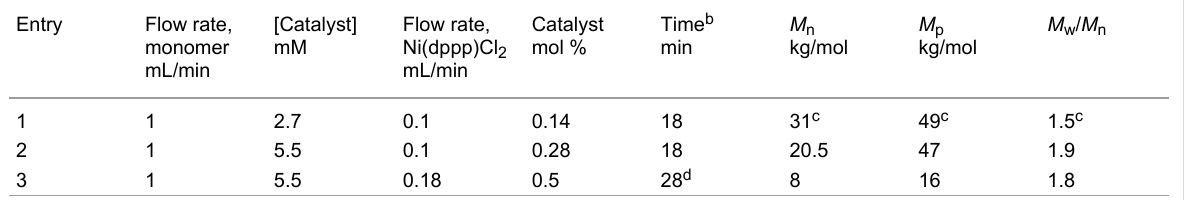
The regioregularity was estimated to be 95% from the integra- tion of the α -methylene protons in the 1 H NMR spectrum (Figure 4). The same degree of regioregularity was observed for a batch sample of similar molecular weight. Additionally, the variation of the molecular weight was investigated when the [M] 0 /[I] 0 ratio was varied. As expected, increasing the concen- tration or the flow rate of the catalyst stock solution, afforded lower-molecular-weight polymers (Table 3, entries 2 and